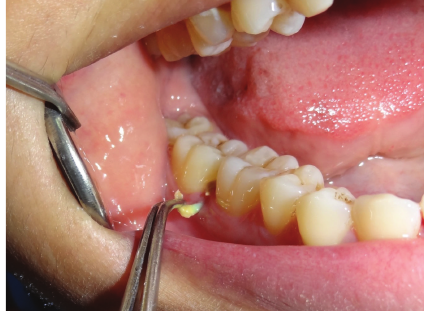
Figure 4: Intact elastic band. Half of the band was covered with heavy plaque while the other half was relatively cleaner.